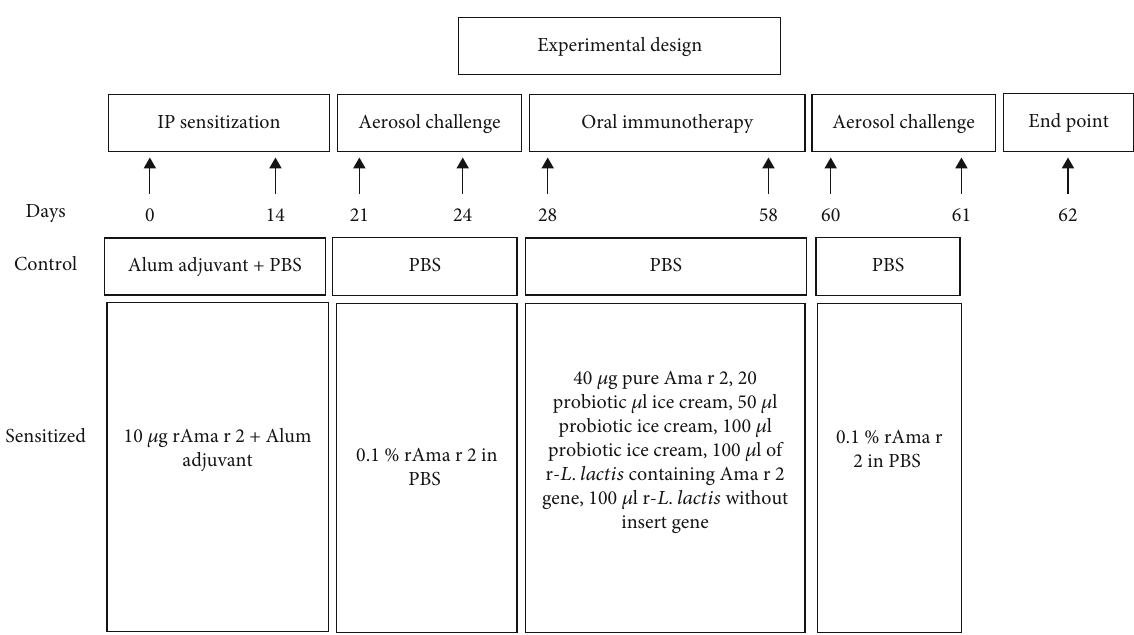
Figure 2: Experimental design. Seven groups of mice ( n = 5 per group) were used in the experiment. Abbreviations: rAma r 2: recombinant Amaranthus retro fl exus pollen; ip: intraperitoneal